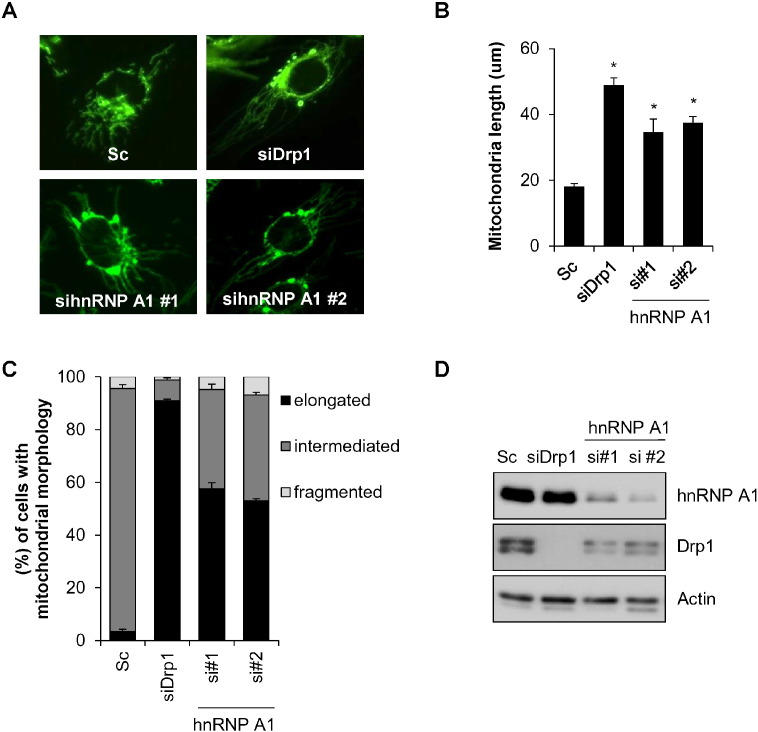
Down-regulation of hnRNP A1 induces mitochondrial elongation.SK-N-MC cells stably expressing mito-YFP (SK-N-MC/mito-YFP) were transfected with control scrambled siRNA (Sc) or siRNA against hnRNP A1 (sihnRNP A1) for 3 days. (A) Representative fluorescence pictures showing mitochondrial morphology. The siRNA for Drp1 (siDrp1) was used as a positive control. (B and C) The mitochondrial length (B) and mitochondrial morphology (C) were monitored using a fluorescence microscope. (D) The expression of hnRNP A1 (si#1, si#2) and Drp1 by their siRNA was confirmed by Western blot analysis with each antibody. Data are represented as the mean ± SEM (n > 3, and *p < 0.05 value).